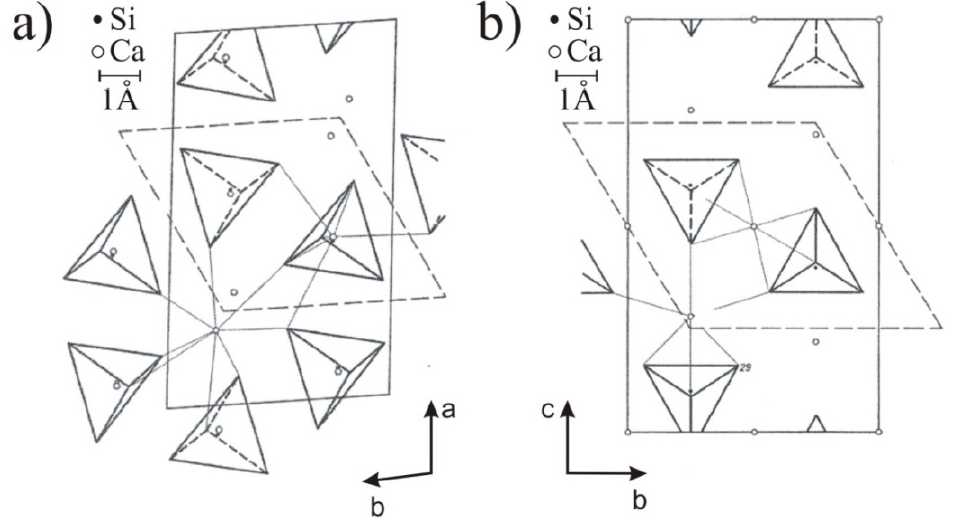
Figure 2. Crystal structures of calcium orthosilicate polymorphs: ( a ) β -C 2 S, ( b ) γ -C 2 S [7].